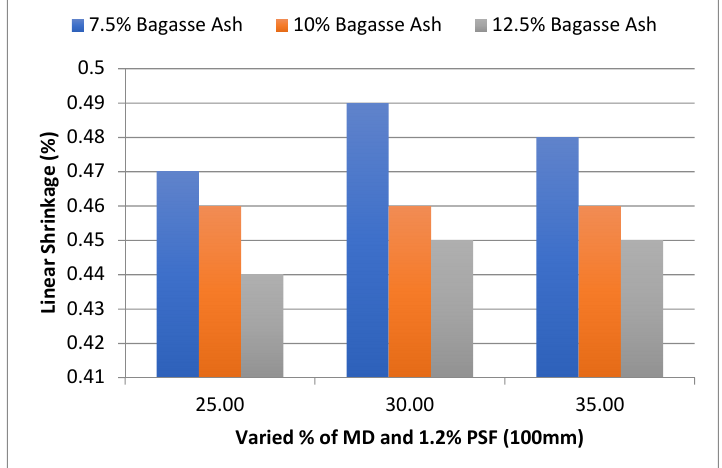
Figure 16. Effect of MD and BA on linear shrinkage of block reinforced with 1.2% PS fiber (100 mm). As shown in Figure 17, at 25% MD and 7.5% BA, the linear shrinkage of the admixed adobe block reinforced with 0.8%, 125 mm paddy straw fiber was 0.68%, which increased to 0.71% with 7.5% bagasse ash and 35% marble dust.